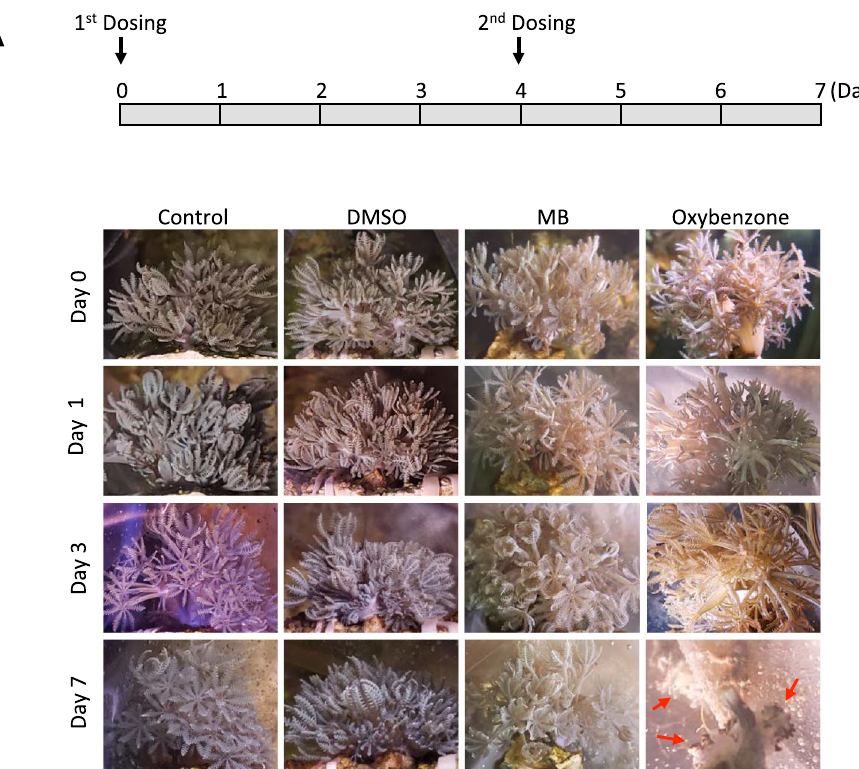
Figure 5. MB is non-toxic to coral health compared to oxybenzone (BP-3). ( A ) Schematic experimental timeline showing the two administrations of PBS control, DMSO 0.005%, 1 μM MB, and 1 μM Oxybenzone on day 1 and day 4, respectively. ( B ) Representative images of coral colonies growing on the stone base in the seawater containing different chemicals on day 0 (before adding chemicals), day 1, day 3, and day 7. Red arrows indicate the death of corals in the Oxybenzone-treated experiment on day